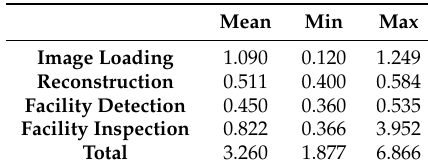
Table 5. Computational time of the proposed system (sec/image).